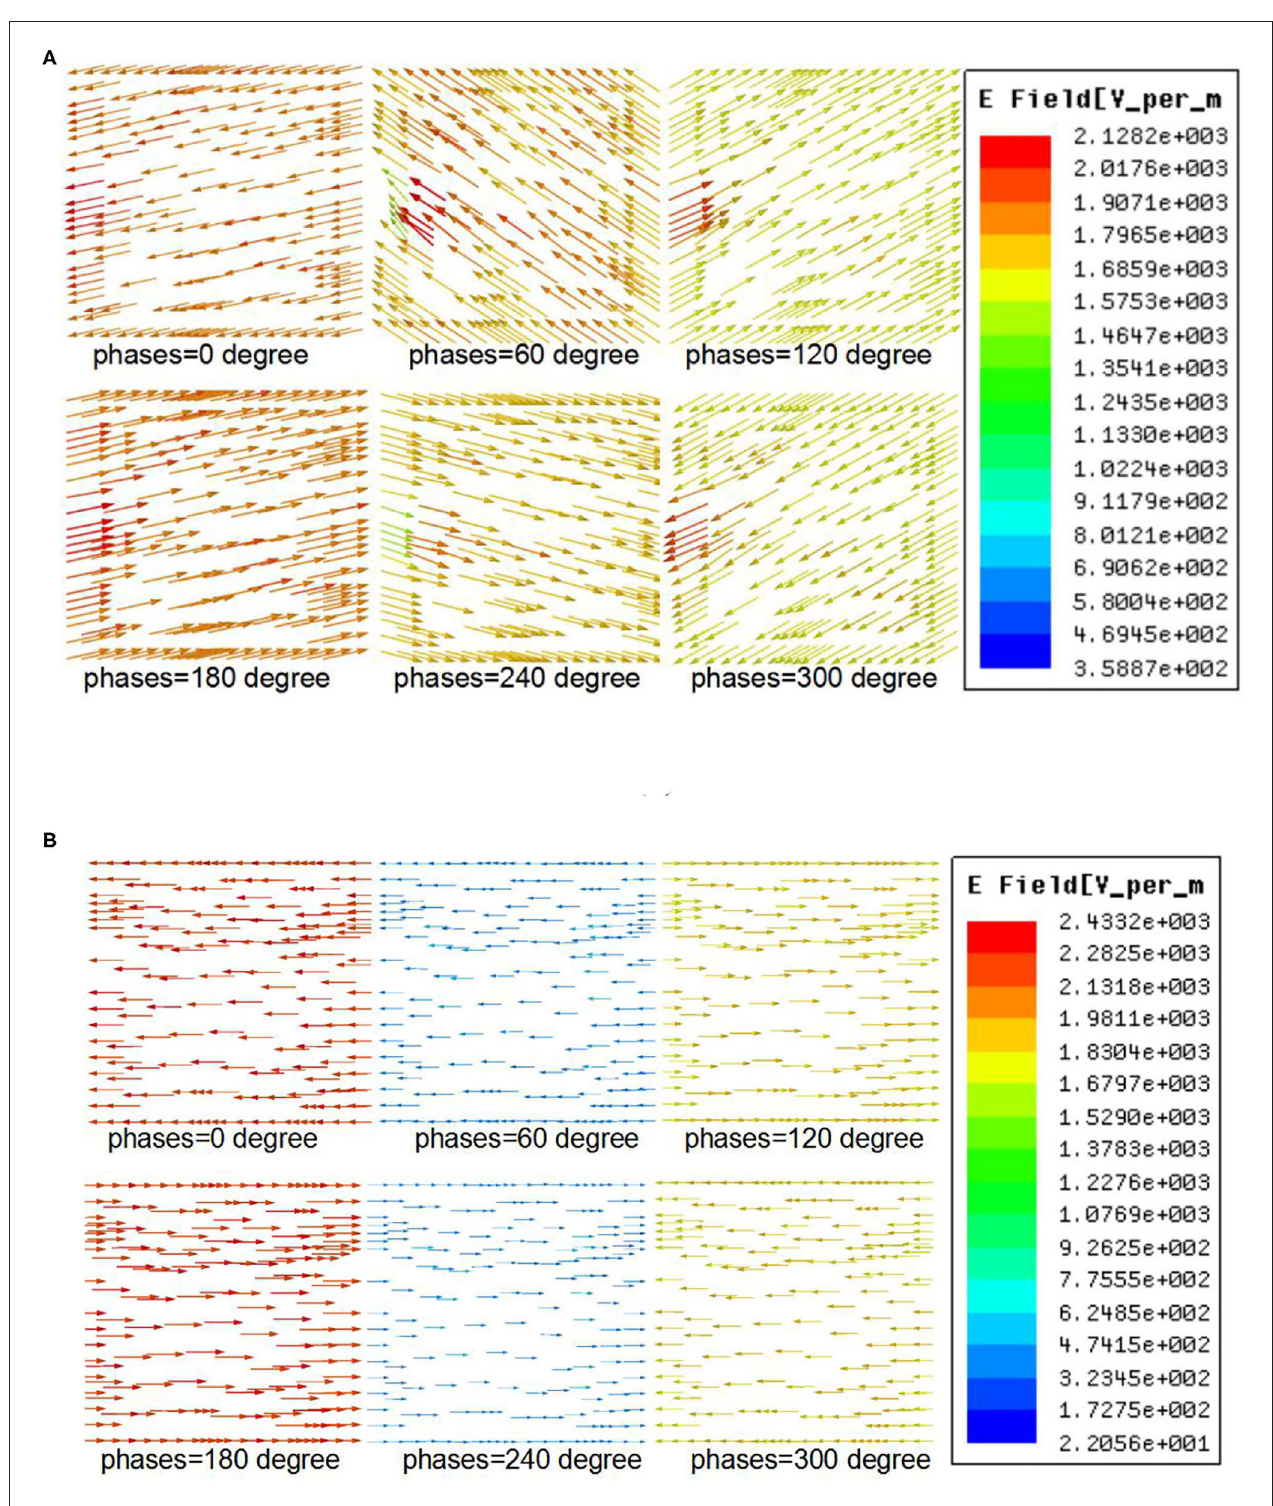
FIGURE 3 | Electric field distribution at f